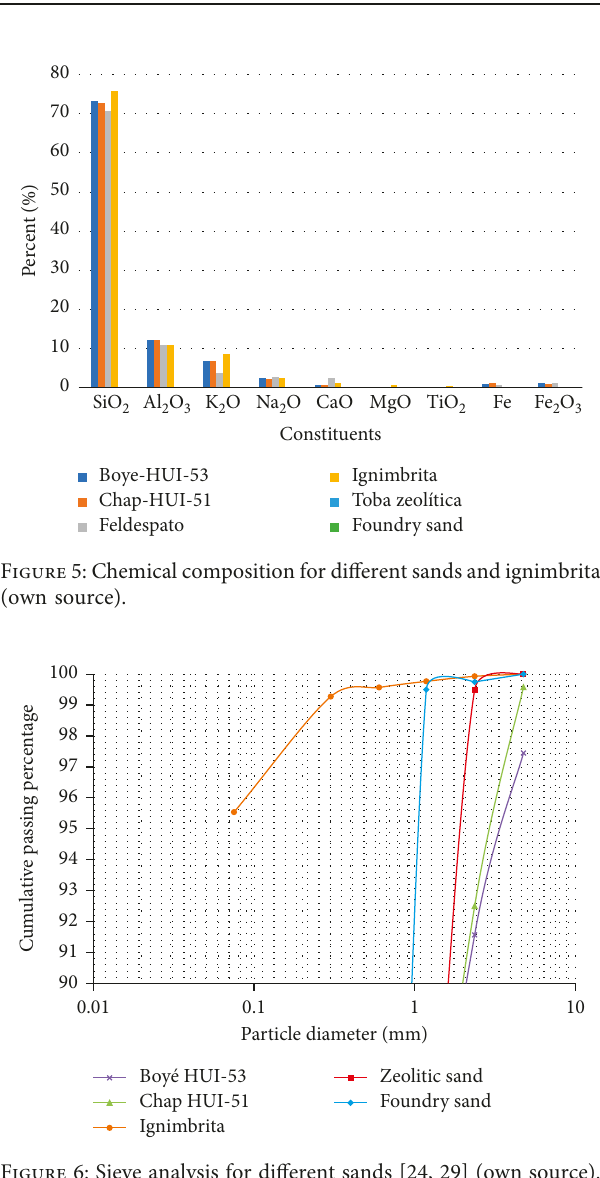
Figure 6: Sieve analysis for different sands [24, 29] (own